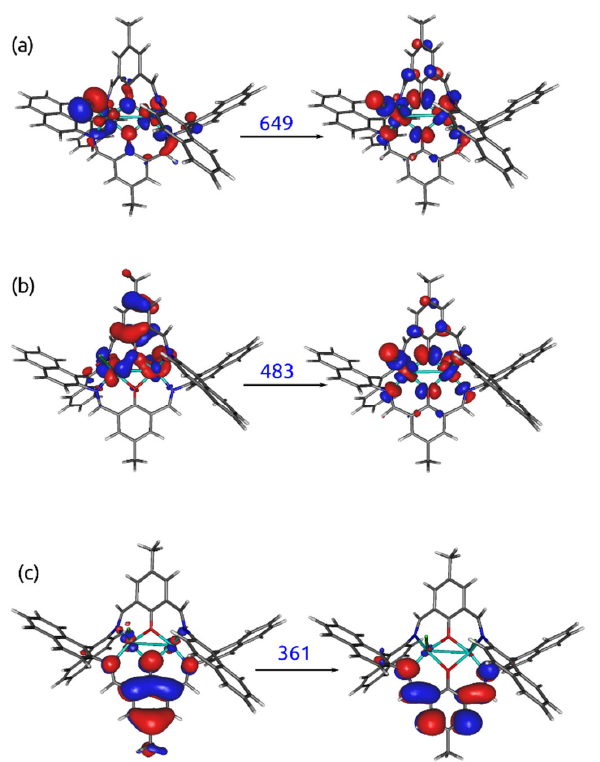
Figure 13. Natural transition orbitals for K1 , corresponding to the most intensive transitions, estimated within the ω B97X ‐ D/def2 ‐ SVP/PCM(CHCl 3 ) approach (( a ) correspond to the d ‐ d* transition, ( b ) to LMCT, and ( c ) to intraligand ππ * transition).